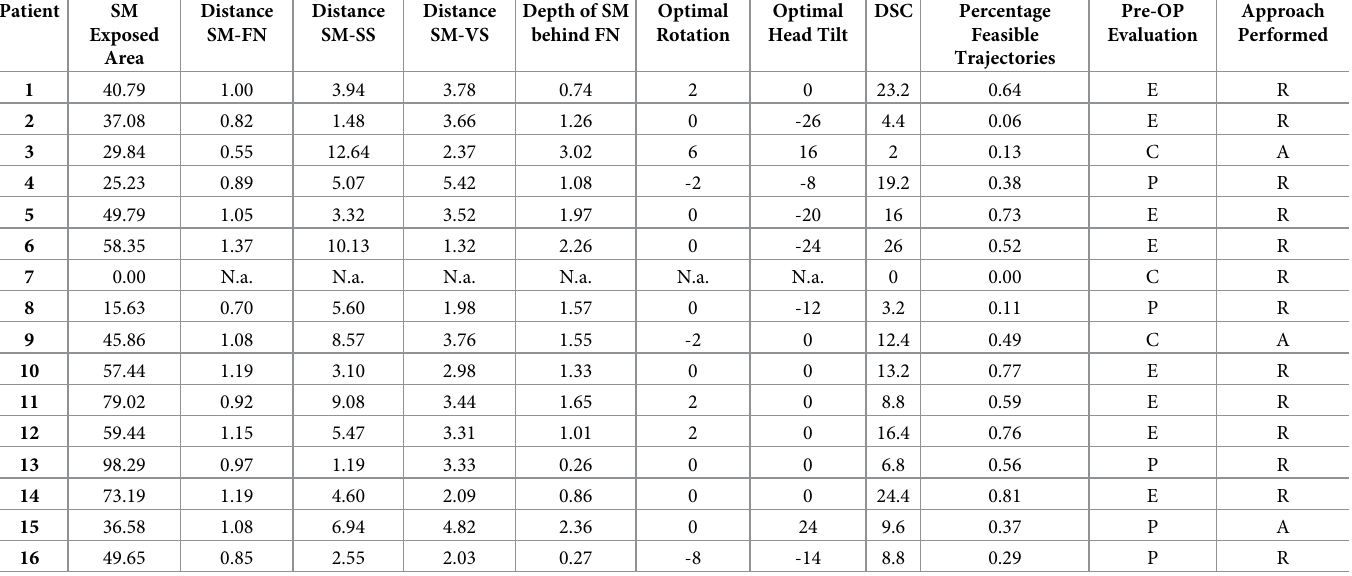
Table 2. Accessibility metrics extracted from the surgical planning tool developed in [20]. Patient SM Exposed